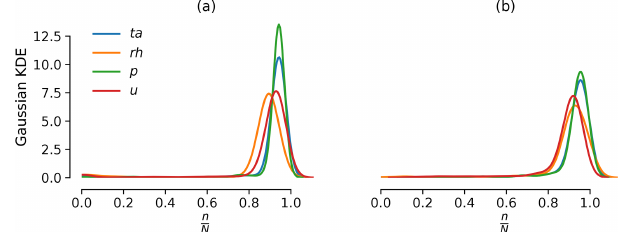
Figure 4. Kernel density estimate of ratio of actual measurement counts ( n ) out of maximum possible count of measurements ( N ), based on the timestamp records in each Level-1 sonde file for (a) HALO and (b) P3. For u , N would be the total timestamp records in any given sonde profile, whereas for the rest it would be half that. In the legend, labels stand for temperature (ta), relative humidity (RH), pressure ( p ) and eastward wind ( u ). The northward wind ( v ) has the same distribution as u and is hence not